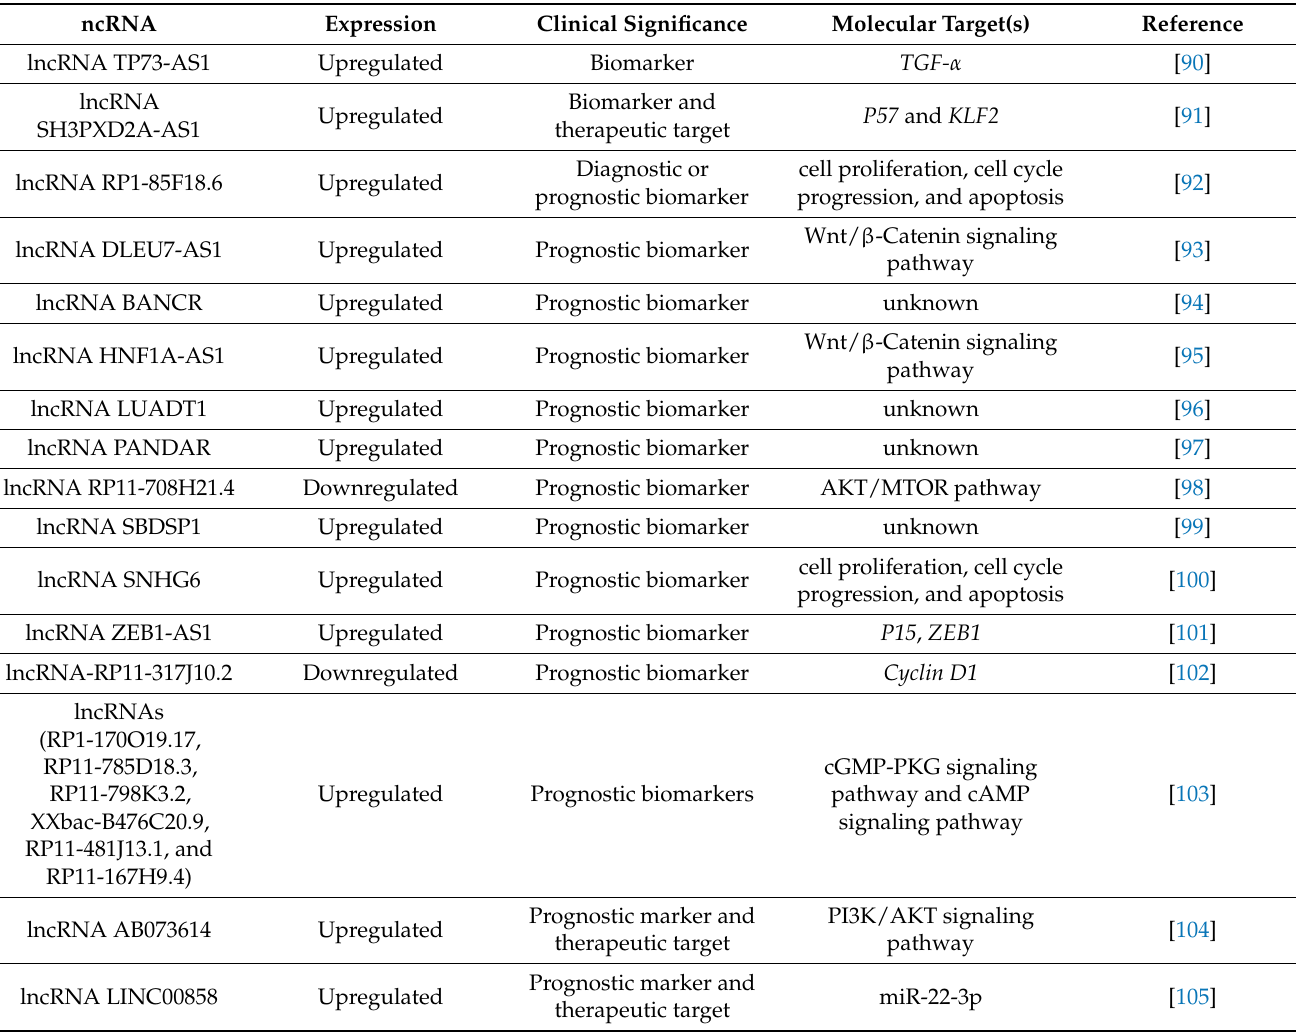
Table 2. List of ncRNAs that could be used as therapeutic targets or biomarkers for colorectal cancer.